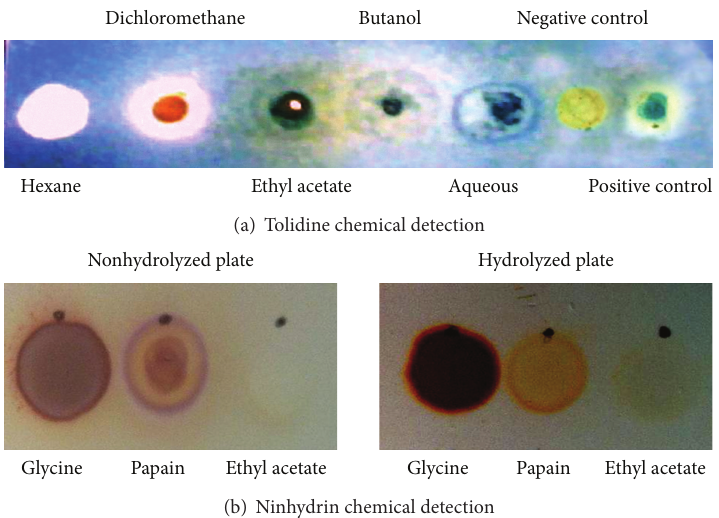
Figure 2: Cyclopeptides in ethyl acetate fraction from C. procera are confirmed by tolidine (a) and ninhydrin chemical detection (b). Table 3: Inhibitory effect of fractions of C. procera latex on carrageenan-induced peritonitis model. Fractions